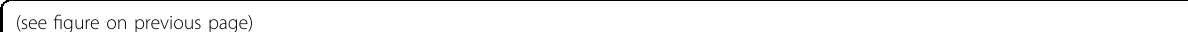
Fig. 6 The roles of STAT3-PIM1 in the rapamycin-induced rescue of CPC senescence. a , b Expression of STAT3 , Pim1 , and Bcl-2 was examined in senescent hCPCs after prolonged rapamycin treatment (* p ≤ 0.05, ** p ≤ 0.01, vs. young, ### p ≤ 0.001, vs. senescent, n = 3). c Proliferation assay of cells treated with the STAT3 inhibitor S31 – 201 in senescent hCPCs after prolonged rapamycin treatment. d Senescence β -gal assay on treatment with STAT3 inhibitor S31 – 201 in senescent hCPCs after prolonged rapamycin treatment (* p ≤ 0.05, *** p ≤ 0.001, vs. senescence hCPCs, ###, *** p ≤ 0.001 n = 3). e Proliferation assay following treatment of senescent hCPCs with the PIM1 inhibitor after prolonged rapamycin treatment. f Senescence β -gal assay on following treatment with the PIM1 inhibitor S31 – 201 in senescent hCPCs after prolonged rapamycin treatment. g The expression of senescence markers p21, p16, and p53 was examined by qRT-PCR after treatment with STAT3 and Pim1 inhibitors (** p ≤ 0.05, *** p ≤ 0.001, vs.